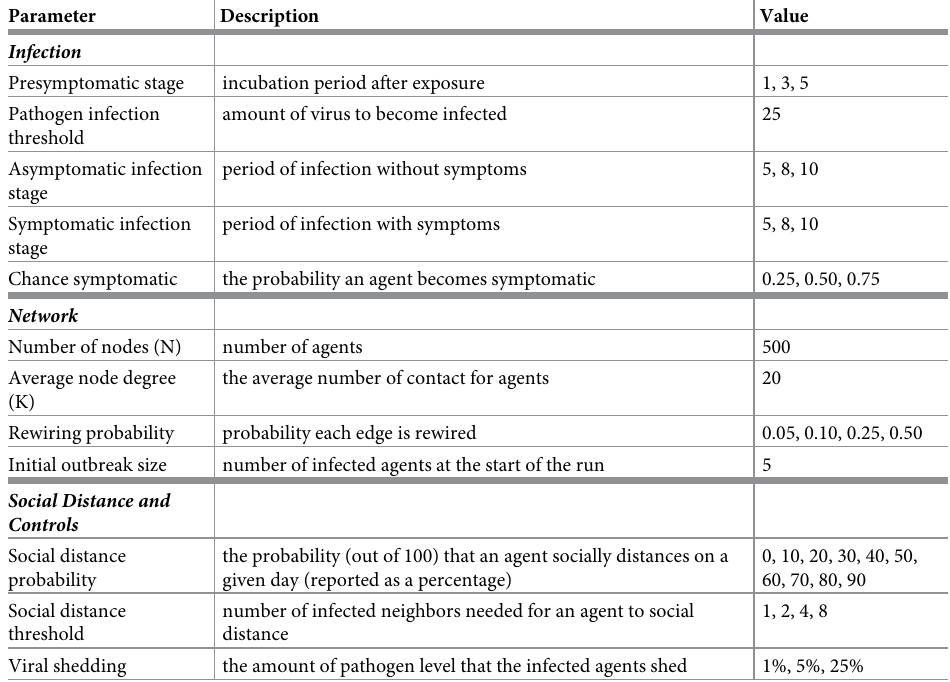
Table 1. Primary simulation